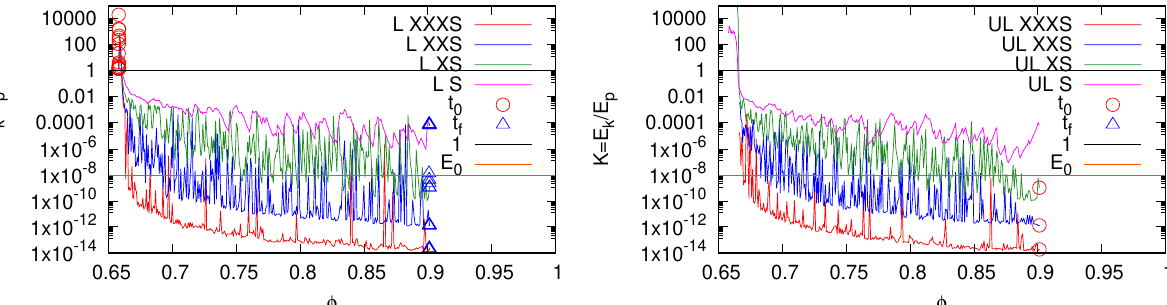
Figure 2. Kinetic to potential energy ratio E k / E p plotted against volume fraction, from the same simulations as in Fig. 1 with same colors / symbols. The horizontal lines are the ratio of unity (1), indicating the dynamic jamming / un-jamming transition point, and E 0 = 10 − 8 , an arbitrary threshold below which the system XXS can be considered static, elastic, reversible in mechanical equilibrium.